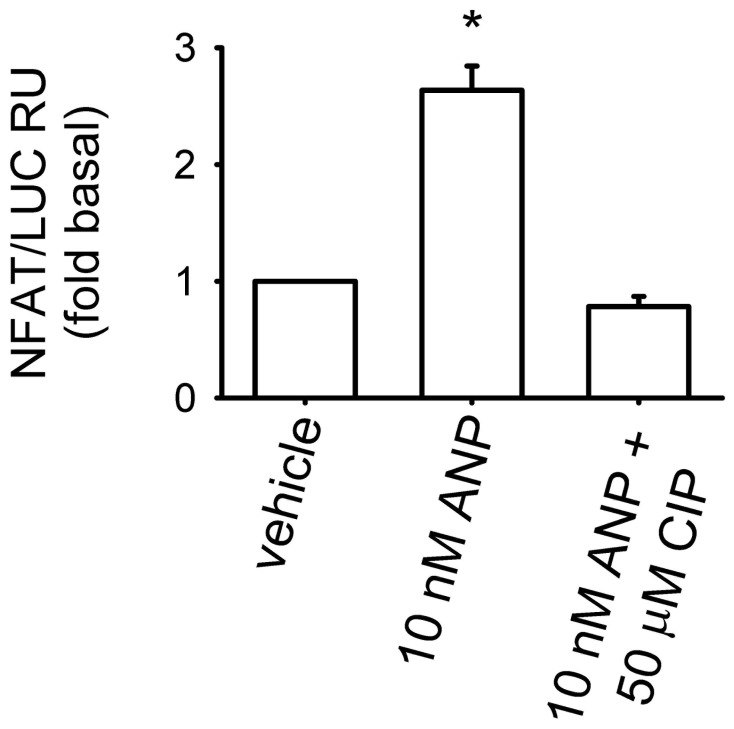
ANP-triggered increased NFAT reporter activity in MA-10 cells.Cells were transiently transfected with plasmids containing NFAT-luciferase reporter (NFAT/LUC) or control plasmid. Forty-eight hours post transfection, cells were treated with vehicle or 50 µM CIP (60 min) followed by 10 nM ANP (20 min). Cells were then washed and allowed to incubate for 1 hour, at which point they were collected for assay of luciferase activity. Results were normalized to protein levels and expressed as fold induction over vehicle control. Experiments were conducted in the presence of 500 µM IBMX. * P<0.05. Data are from at least three experiments.